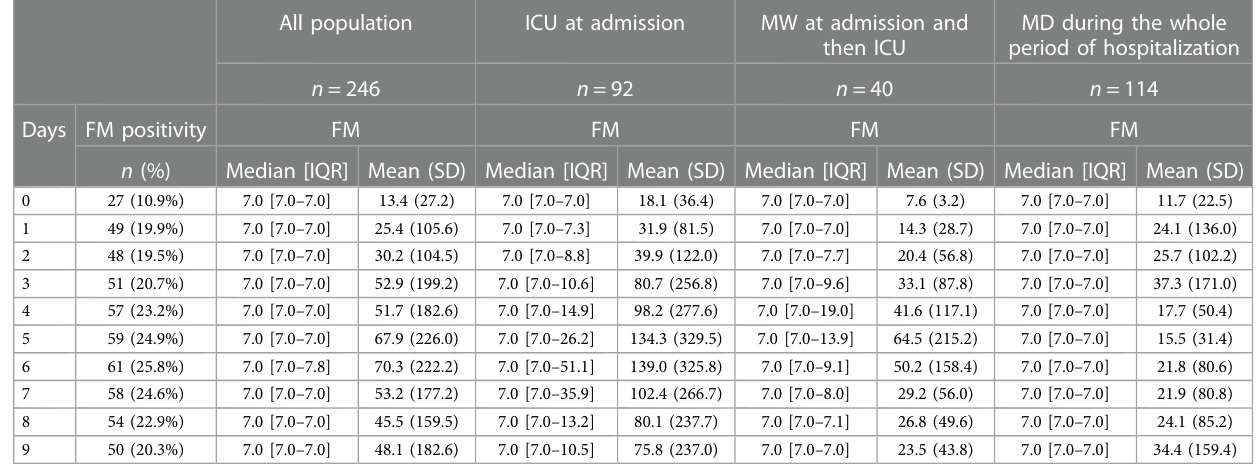
TABLE 1 Patients ’ value of fi brin monomers during hospitalization for